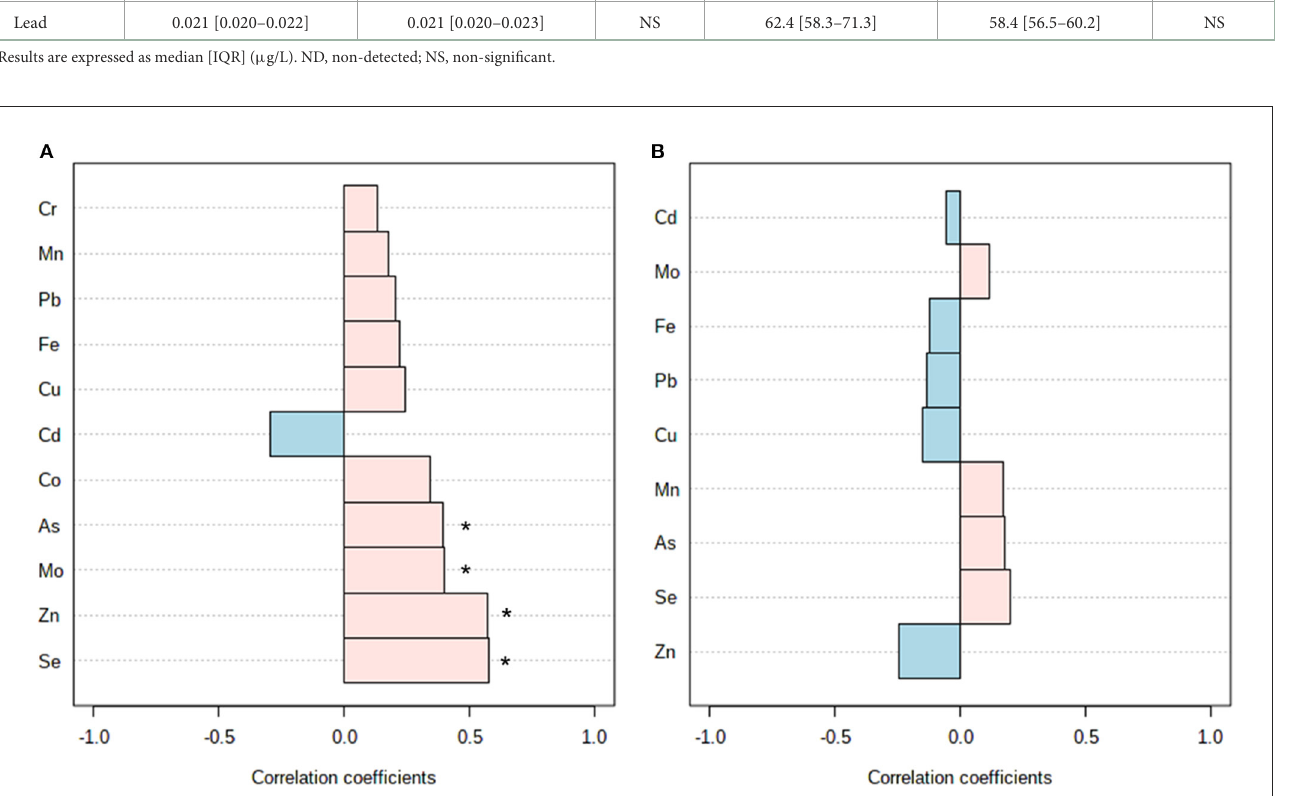
FIGURE1 Correlation analysis between the KIDMED score and multi-elemental data from plasma (A) and erythrocytes (B) . *Denotes significant correlation ( p < 0.05).